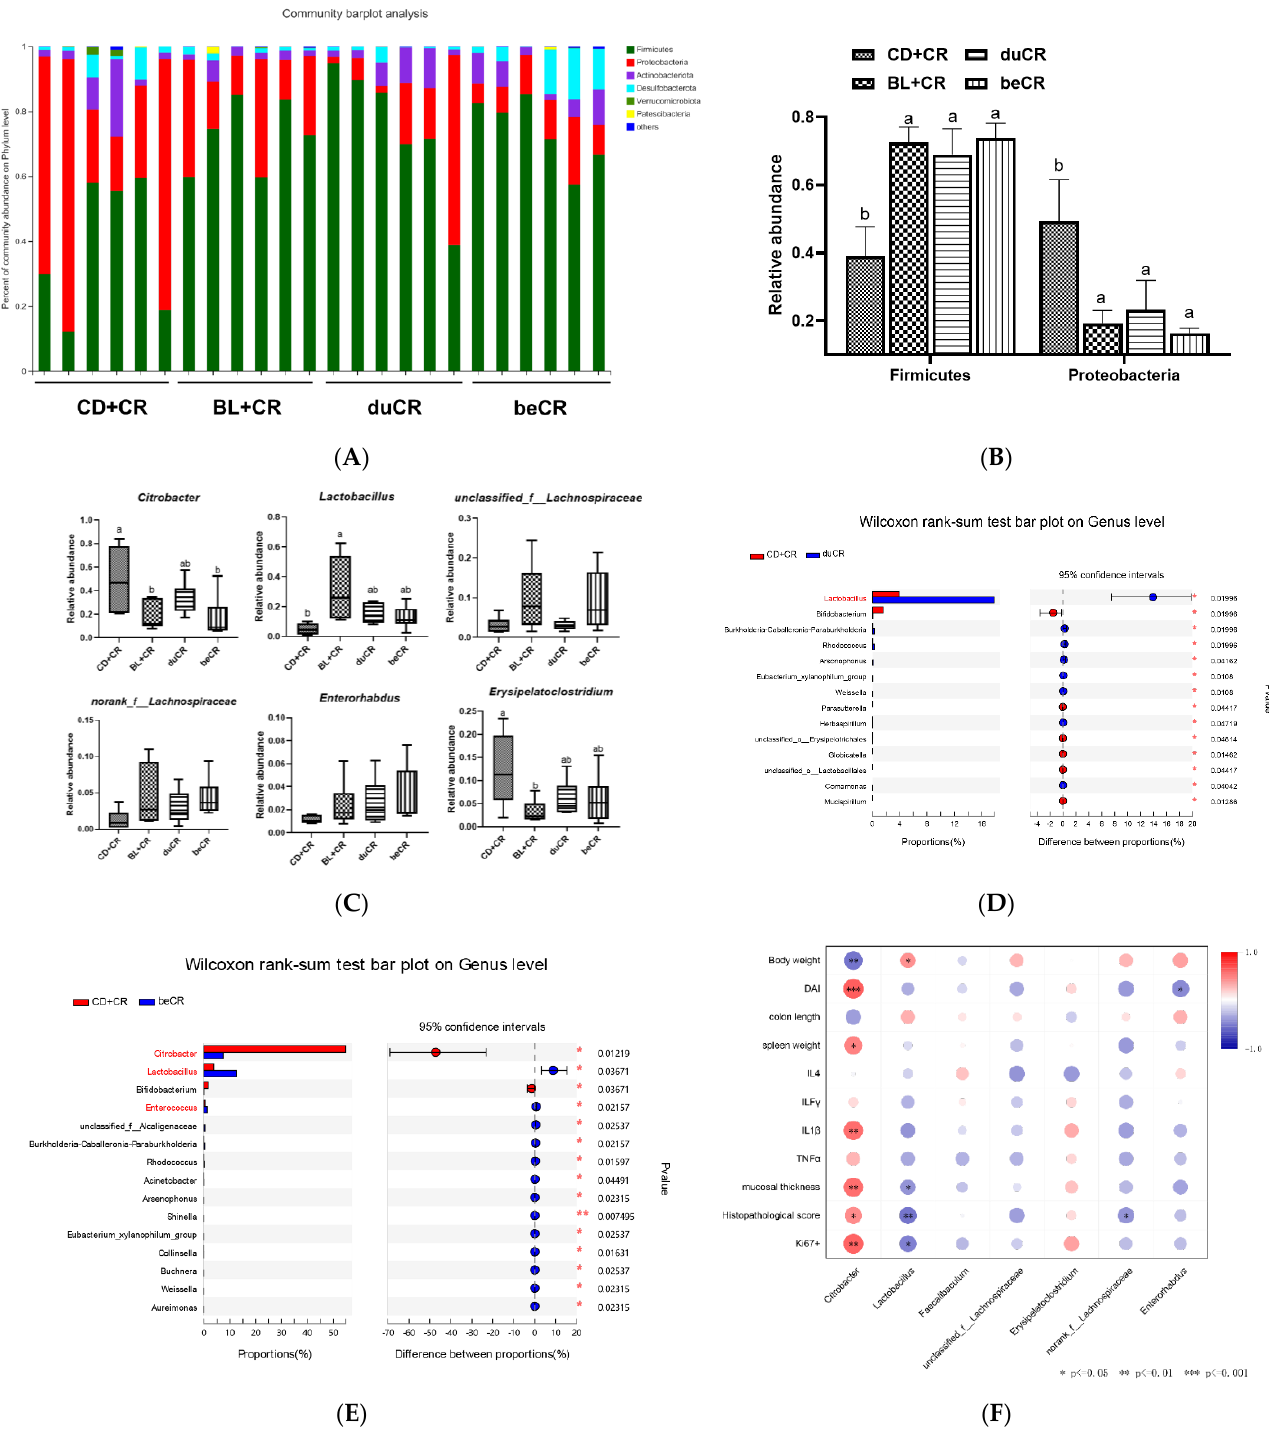
Figure 6. Effect of the beCR and duCR intervention on regulating taxonomic microbial community profiles. ( A ) Taxonomic distributions of gut bacterial composition at the phylum level. ( B ) Relative abundance of Firmicutes and Proteobacteria. ( C ) Relative abundance of Citrobacter, Lactobacillus, unclassified_f_Lachnospiraceae, norank_f_Lachnospiraceae, Enterorhabdus, and Erysipelatoclostridium . ( D ) Wilcoxon rank-sum test of group CD+CR and duCR at the genus level. ( E ) Wilcoxon rank-sum test of group CD+CR and beCR at the genus level. ( F ) Spearman correlations analysis between the microbiota and colitis-related index. The a, b means in the same bar without a common letter differ at p < 0.05.